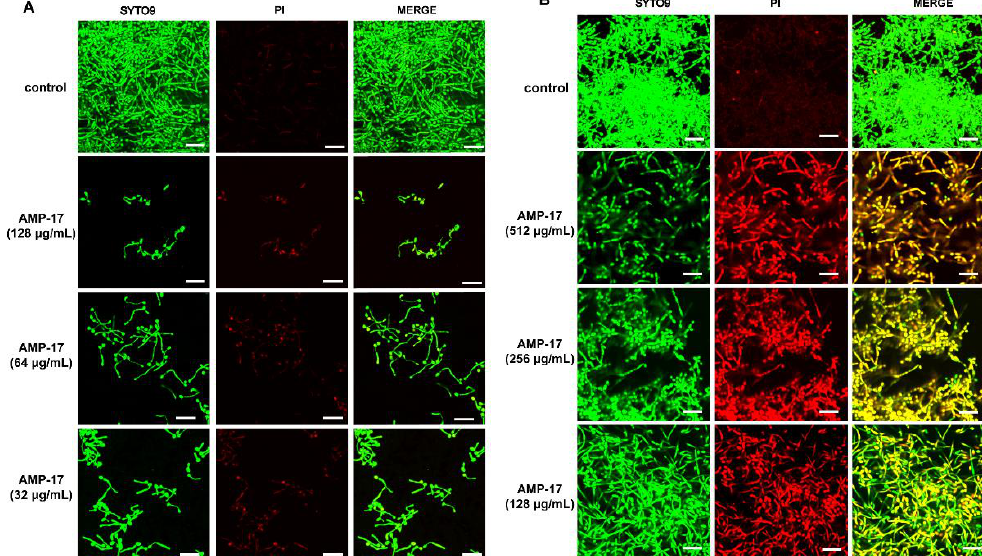
Figure 2. The effect of AMP-17 against biofilm formation and mature biofilm was shown in CLSM. Biofilms were stained with SYTO9 and PI, and images were captured using a confocal laser scanning microscope. Live cells were stained in green and dead cells in red. ( A ) The effect of AMP-17 on biofilm formation C. albicans cells (10 6 CFU/mL) incubated on plastic coverslips at 37 °C for 12 h in the presence or absence of AMP- 17 at concentrations of 32 μg/mL, 64 μg/mL, and 128 μg/mL. The AMP-17-treated C. albicans biofilms exhibited a few cells adhered and no biofilm structure was found. ( B ) The effect of AMP-17 against mature biofilm. After the C. albicans biofilm was incubated at 37 °C for 24 h to mature, it was treated with different concentrations of AMP-17 (12 8 μg/mL, 256 μg/mL, and 512 μg/mL). Preformed biofilms exposed to AMP -17 exhibited a high dead cell rate in the biofilms. SYTO9 and PI were used to distinguish viable and dead cells. Bar, 20 μm.